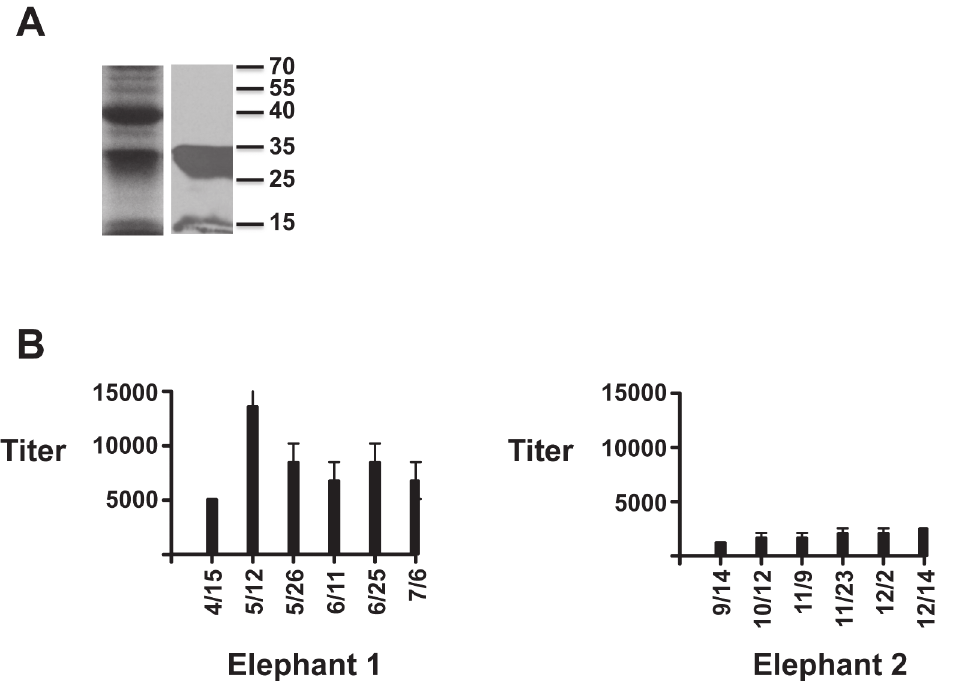
Fig 6. Anti-EEHV1 gL serum titers in two elephants with documented EEHV viremia and shedding. A) Recombinant EEHV gL expressed in e. coli and purified using metal affinity chromatography. The panel on the left is a coomassie stained gel of purified gL protein and the panel on the right is the same protein detected in an immunoblot using an anti-histidine antibody. Molecular weight markers are indicated on the right. B) The graphs show anti-gL IgG antibody titers (y-axis) for serum from an adult female Asian elephant (elephant 1) and a juvenile male elephant (elephant 2). Samples were tested on days indicated below the x-axis. The results are shown as the mean plus standard deviations from three independent experiments in which each independent experiment had four replicates for each dilution.